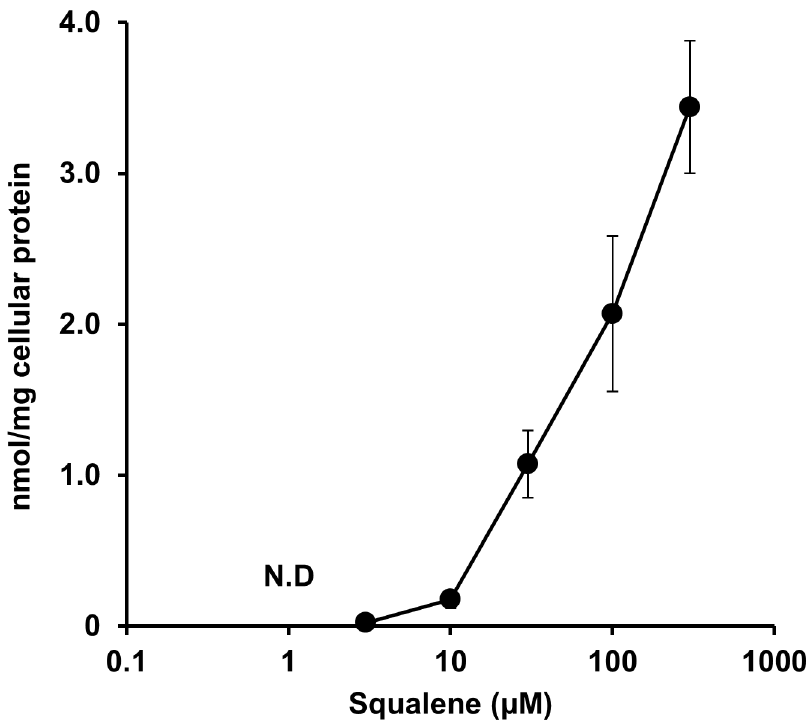
Fig 1. Squalene uptake in cultured cells. Squalene uptake by A549 adenocarcinoma cells. The cells were incubated with various concentrations of squalene (0 – 300 μ M) for 3 h, washed in PBS, and harvested. Squalene was extracted from the cells using chloroform/methanol, and the amount of squalene was determined by GC-MS.